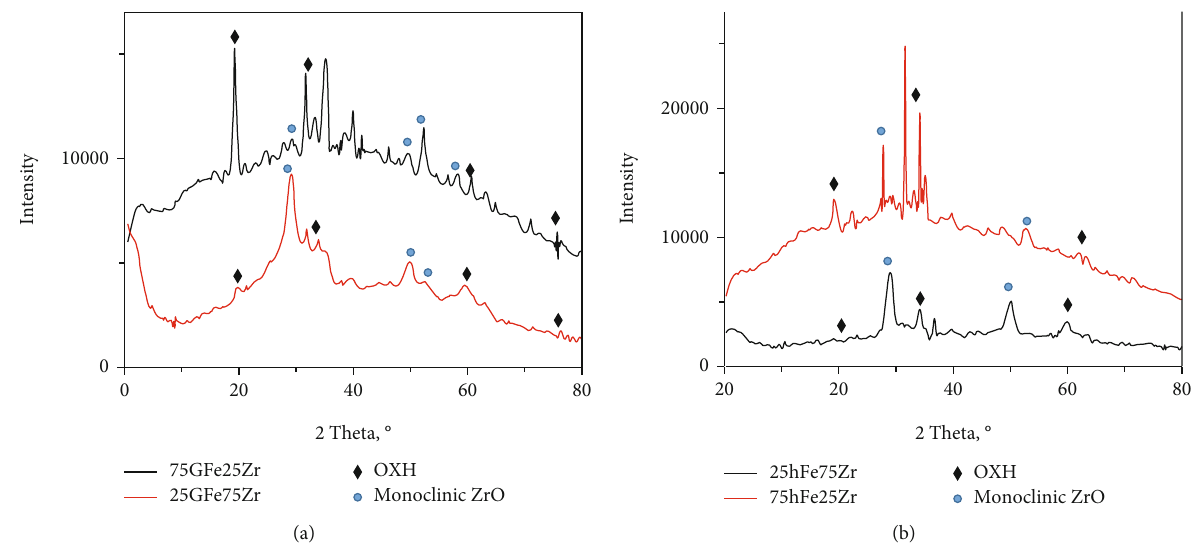
Figure 2: X-ray di ff raction patterns of catalyst samples used in the degradation of 4-nitrophenol.